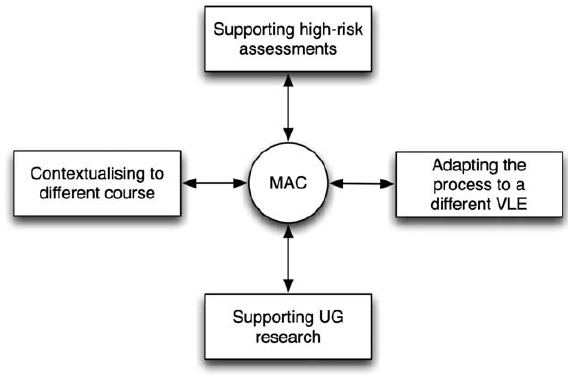
Figure 6. Enhancement of the MAC process by working as a